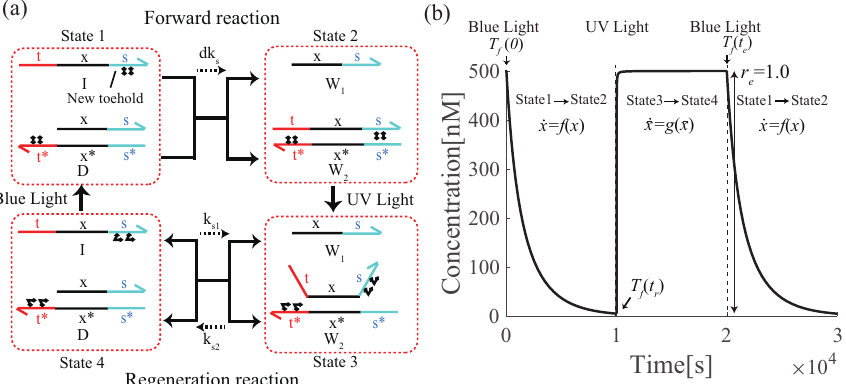
Figure 5. ( a ) Azo-degradation circuit; and ( b ) simulation results of input I for azo-degradation. The concentrations of D and I is 1000 nM and 500 nM, respectively. The binding strength d is 0.0008, and the reaction rate k s = 1.0 × 10 − 3 nM − 1 s − 1 . The toehold length is 5 nt, the length of the recognition domain is 15 nt, and the concentration of the initial fuel strand ( D ) is 1000 nM. The specific reaction rates are listed in Table